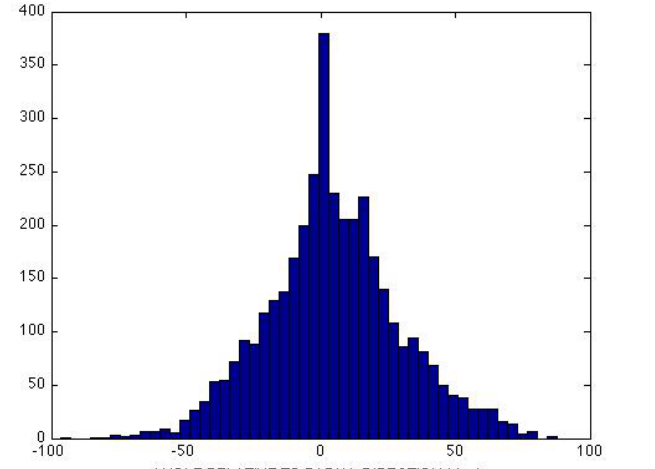
Figure 4. Histogram of IR brightness temperature gradient vectors relative to radial direction for Cyclone Monica 1610 UTC MODIS data. Y-axis is relative count. The variance computed from this histogram is 508